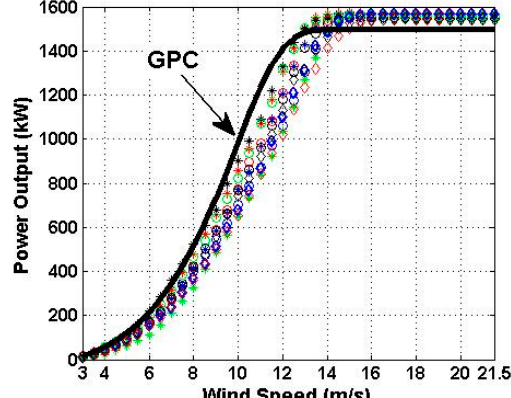
Figure 5. Power curves of the wind turbines (WTs) of the Villonaco Wind Farm in the year 2014, and the Guaranteed Power Curve (GPC). WT-1: Blue *; WT-2: Red *; WT-3: Black *; WT-4: Green *; WT-5: Blue o; WT-6: Red o; WT-7: Black o; WT-8: Green o; WT-9: Blue ⋄ ; WT-10: Red ⋄ ; WT-11: Black ⋄.